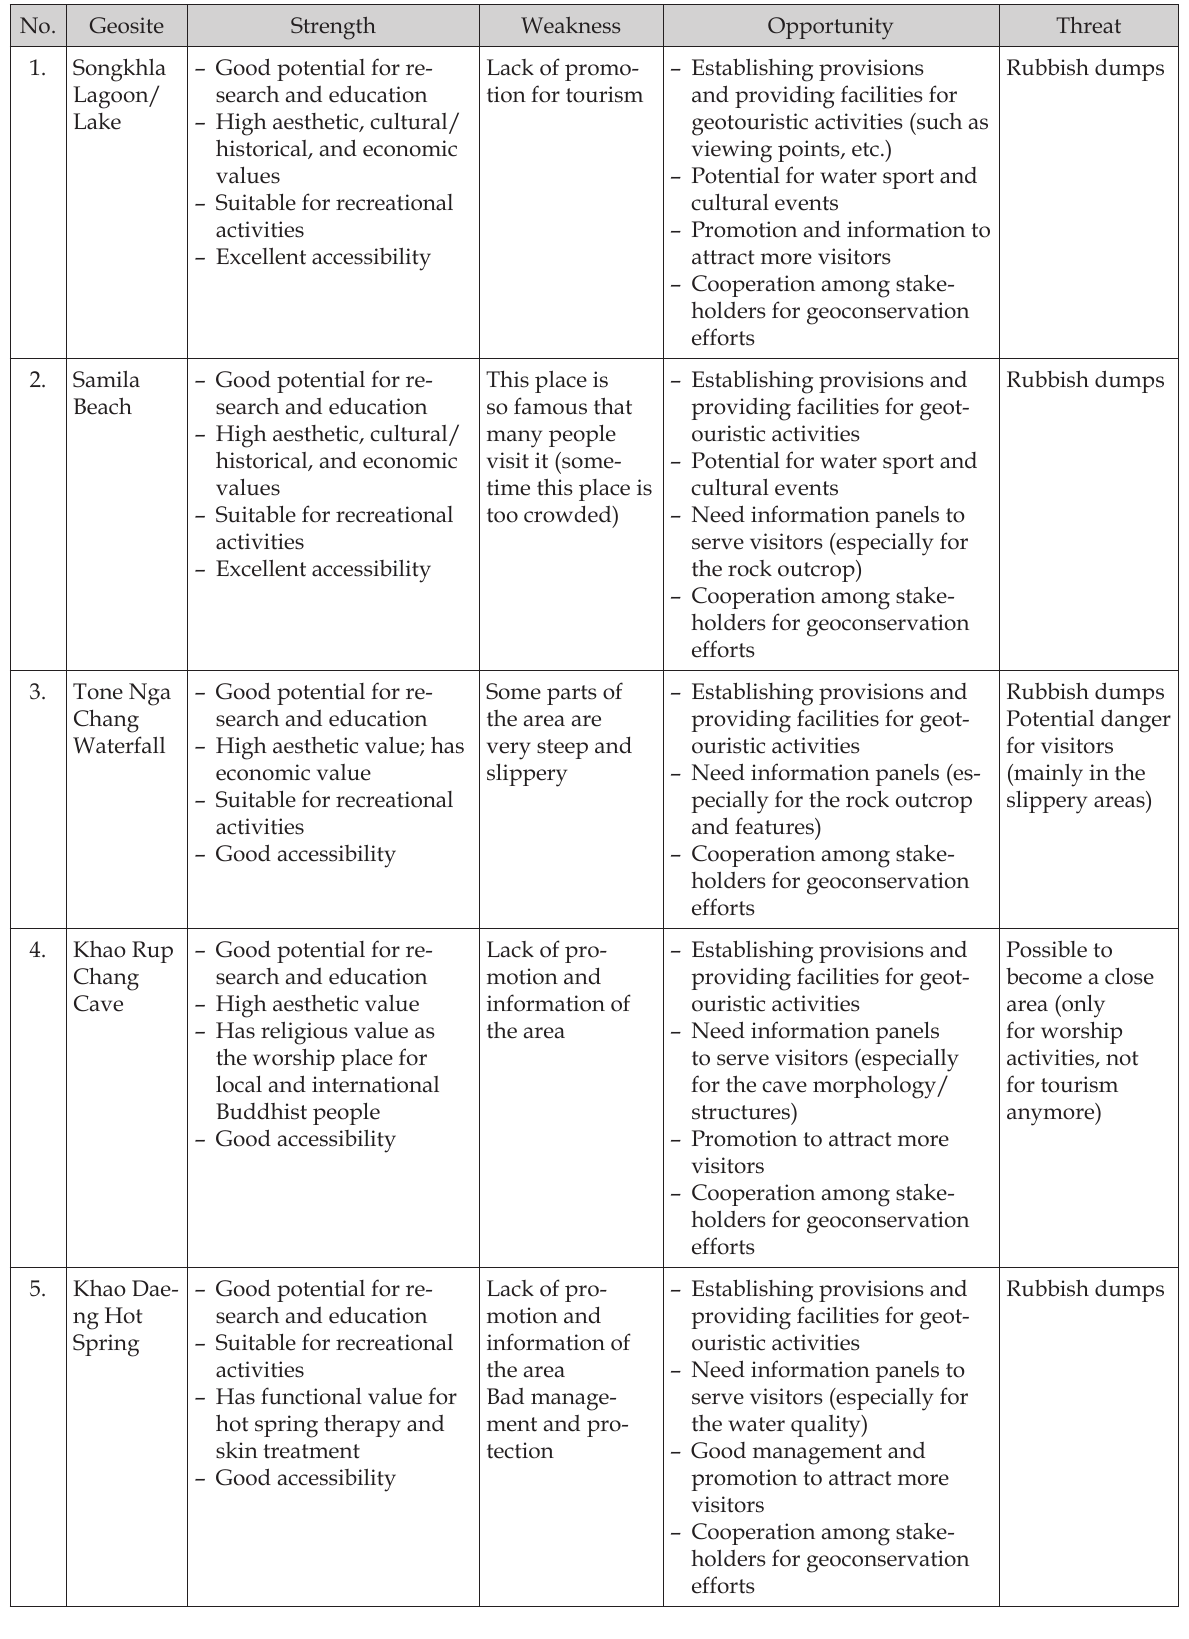
Table 5. SWOT analysis to evaluate the selected geosites for geoconservation and development in Songkhla Province,